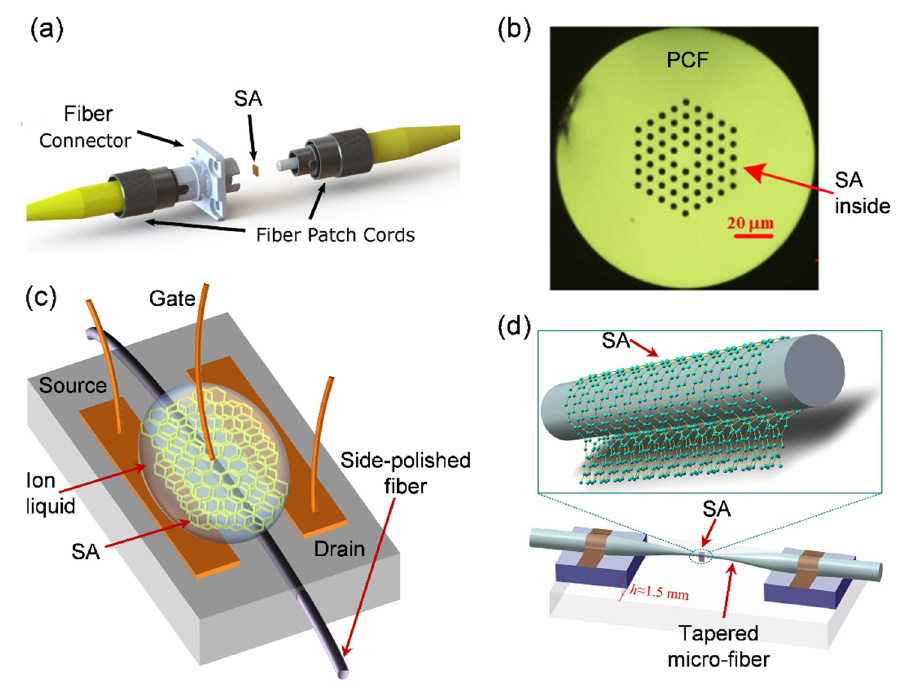
Figure 4. Various schemes for incorporating LD SAs in optical fiber. ( a ) SA sandwiched between two fiber connectors. Reproduced with permission [126]. Copyright 2015, The Optical Society of America. ( b ) LD SA injected inside a hollow photonic crystal fiber (PCFs). Reproduced with